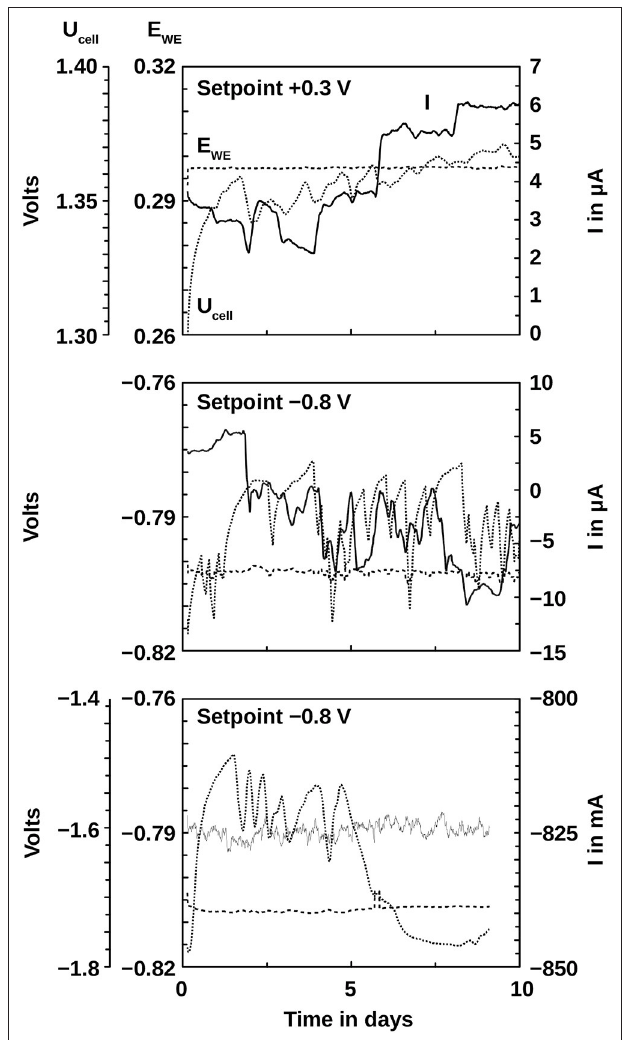
FIGURE 2 | Results of three test runs of the potentiostat software with different setpoints: top setpoint + 0.300V in one H-cell, middle setpoint − 0.800V in the other H-cell, bottom setpoint − 0.800V in a 7l tube reactor; U cell , measured cell voltage, E WE , measured working electrode